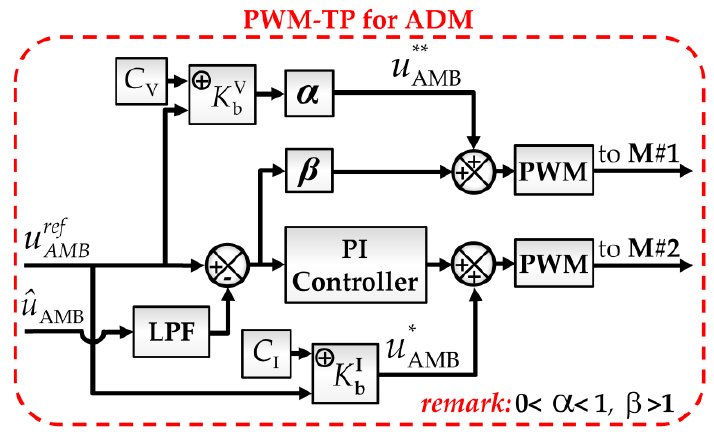
Figure 7. Schematic diagram for PWM-TP (pulse width modulation-tuning processors) under ADM (analog driving mode).